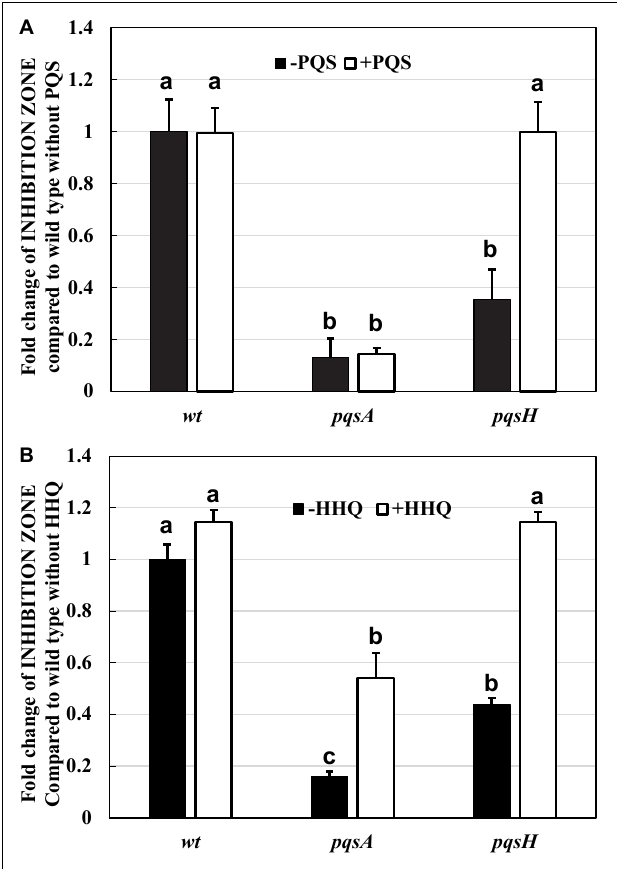
FIGURE 2 | Restoration of the inhibitory effect by two quinolone compounds, PQS (A) and HHQ (B) , on the predation plate assays using a mixture of